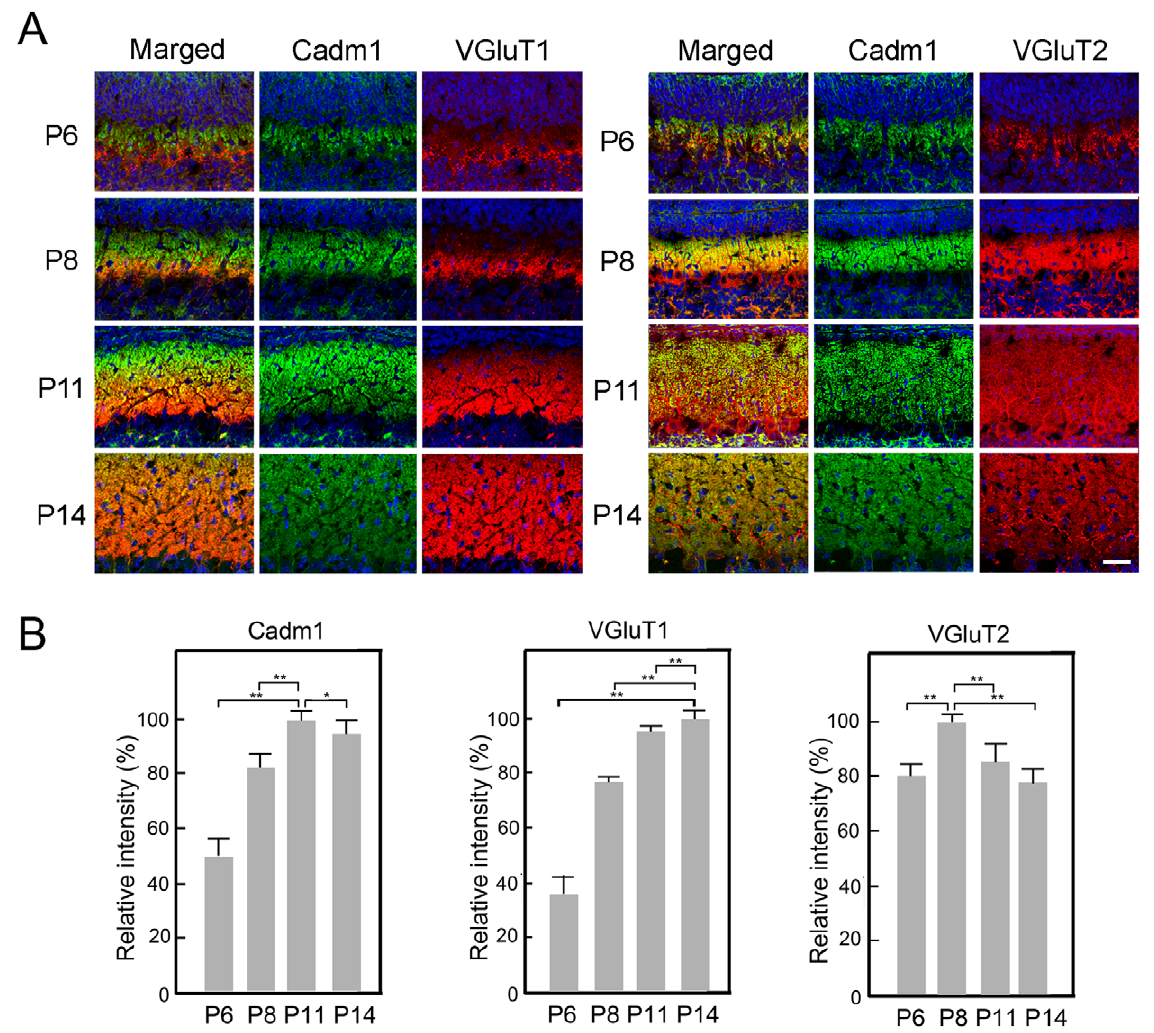
Figure 4. Developmental changes of Cadm1, VGluT1, and VGluT2 in wild-type pups. Alteration of the distribution of Cadm1, VGluT1, and VGluT2 was examined in the molecular layer of the developing cerebellum (P6–14). VGluT2 first appeared in the molecular layer in the early postnatal cerebellum (P6–8), in which Cadm1 co-localized with VGluT2, and then the level of VGluT2 decreased. VGluT1 increased in the later postnatal cerebellum (P11–14), in which Cadm1 co-localized with VGluT1. Green, Cadm1. Red, VGluT1 or VGluT2. Blue, Hoechst. Bar, 30 m m. Values are mean 6 standard error (SEM). Student’s t -test (* p , 0.05, ** p , 0.01). Pups: n=3. Images: n=8.